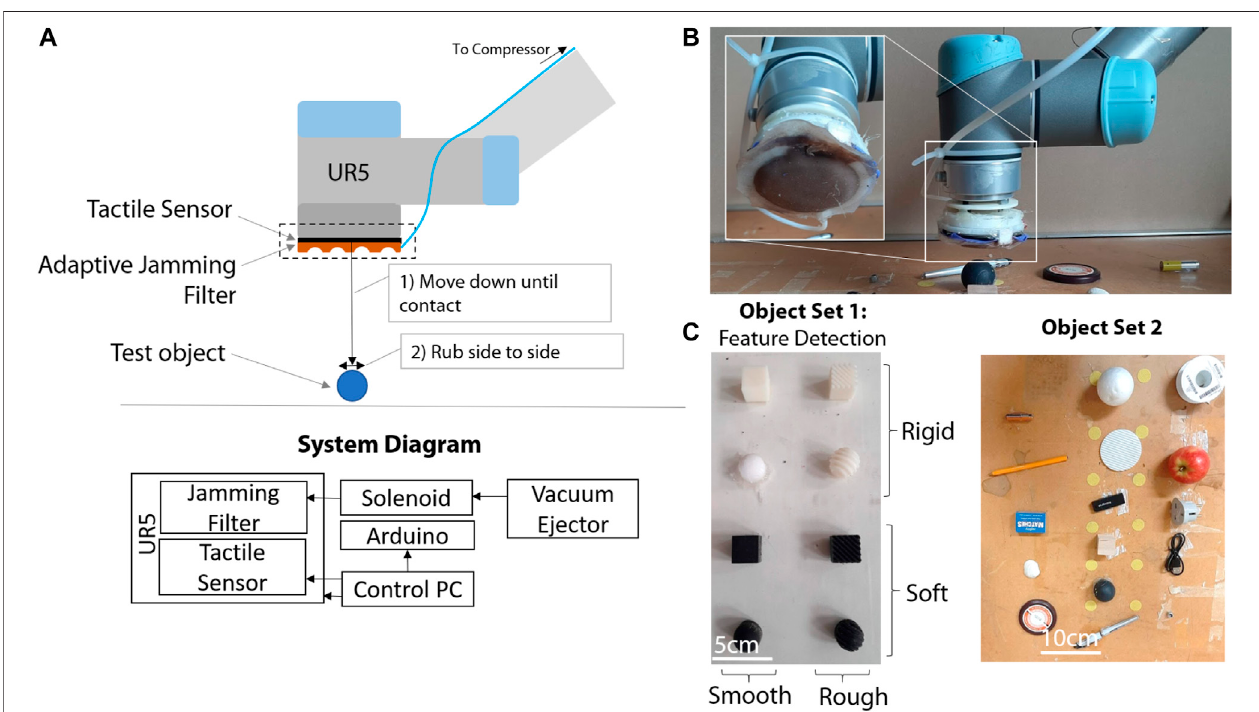
FIGURE4|(A) Diagramshowingthecomponentsoftheexperimentalsetupandablockdiagramofthesystem, (B) Experimentalsetupshowingtheadaptive fi lter, the UR5, (C) Test object sets. The “ soft ” objects are printed in Tango Black (26 – 28 Shore A hardness) using a Objet Connex 3D printer, and the rigid objects with VeroWhite (83 – 86 Shore D Hardness). The rough objects have ridges of 2.5 mm separation.